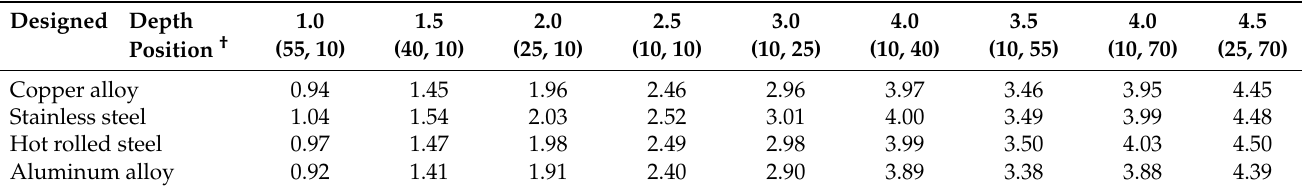
Table 1. Measured values of the defect